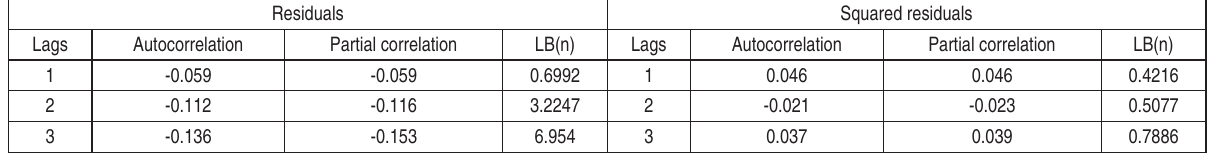
Table 3. Diagnostics on standardized and squared standardized